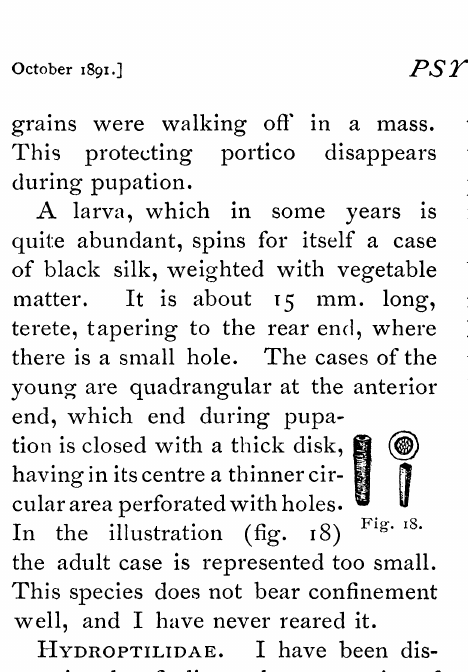
rocks, pebbles or sticks in the brook. The whole is lined with silk,